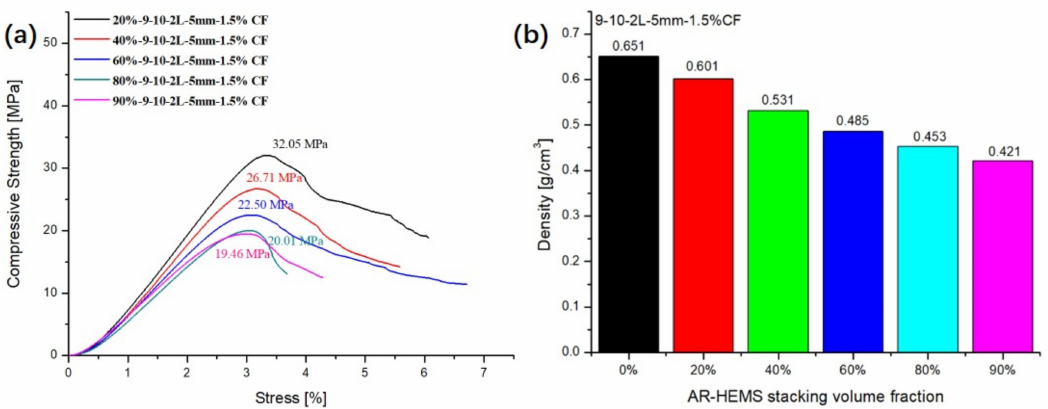
Figure 7. Influence of the stacking volume fraction: ( a ) compressive strength and ( b )